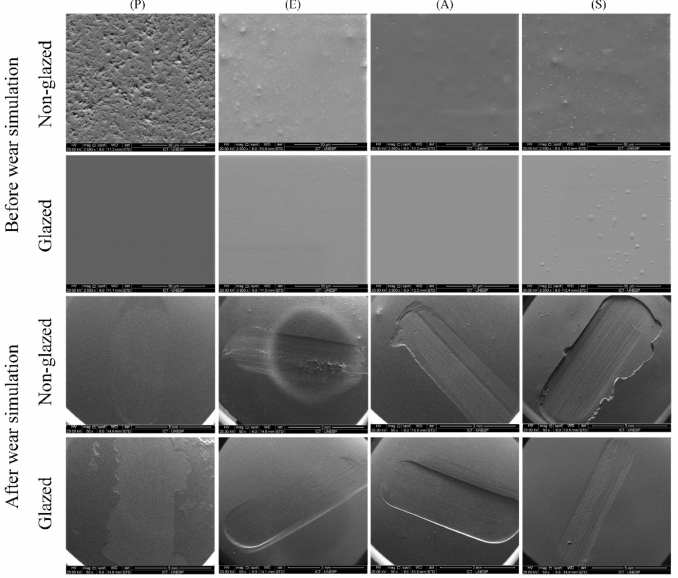
Figure 4. SEM images of the specimen surfaces after 5000 cycles of wear simulation at 50 × magni- fication. Before wear simulation (2500 × ), only non-glazed P specimens showed irregular surfaces, whereas all groups, including glazed specimens, showed uniform surfaces. After wear simulation, wear craters were evidenced in all groups.